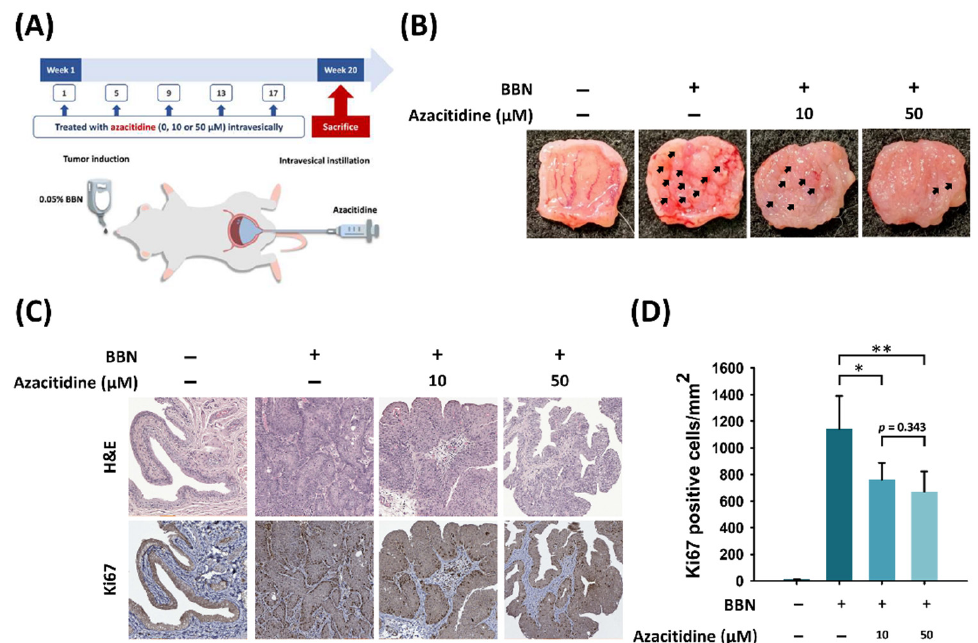
Figure 5. Azacitidine inhibits in vivo tumor growth and lesions in a rat BBN model of bladder cancer. ( A ) Flow chart of the animal model. Bladder tumors were induced in rats by supplying 0.05% BBN in their drinking water. Rats then underwent intravesical instillation of azacitidine (10 or 50 µ M) at 1, 5, 9, 13, and 17 weeks and were sacrificed at week 20. ( B ) Images of bladder tumor lesions in each group. Azacitidine decreased the tumor lesions in the rat bladder. ( C ) Azacitidine instillation alleviated cell proliferation in the BBN-induced rat model, as indicated by H&E staining and immunohistochemistry staining for Ki67. ( D ) Azacitidine treatment alleviated the proliferation of bladder tumors. Quantitative analysis of Ki67-positive cells of bladder section in each group. Data are the mean ± s.d. (* p < 0.05; ** p <